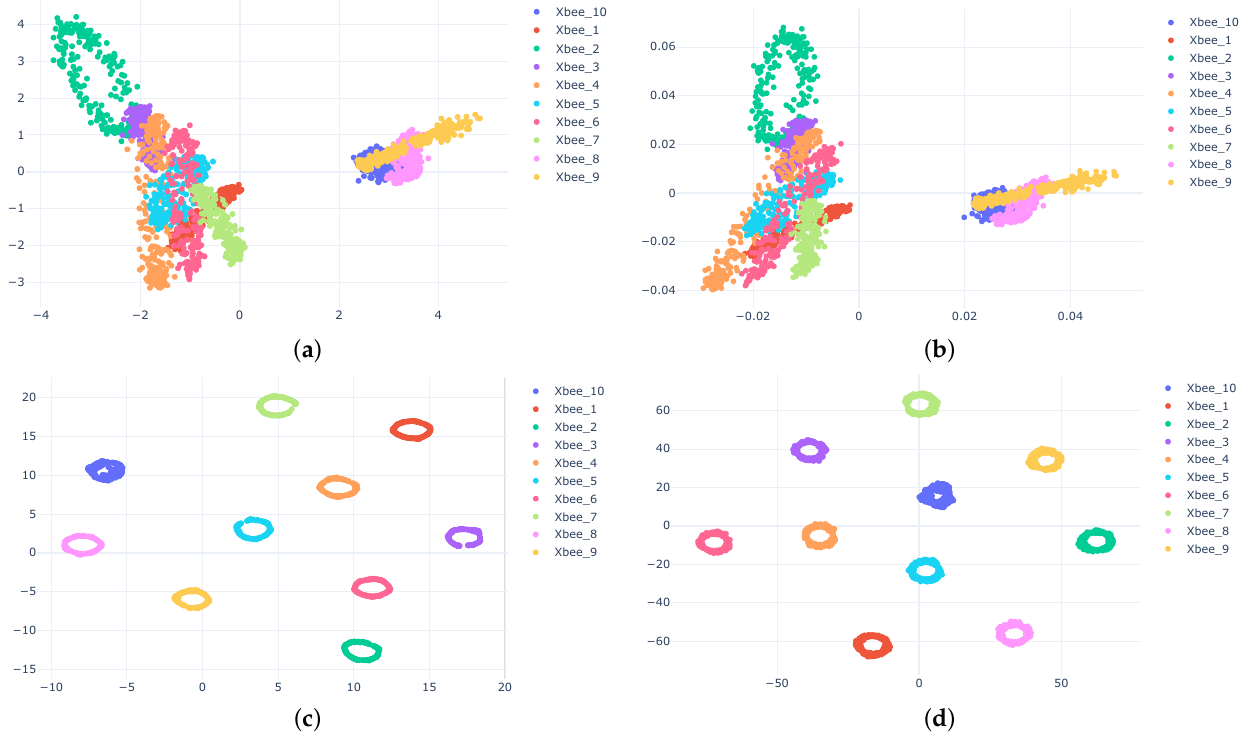
Figure 11. Clustering results using PCA ( a ), ICA ( b ), UMAP ( c ) and t-SNE ( d